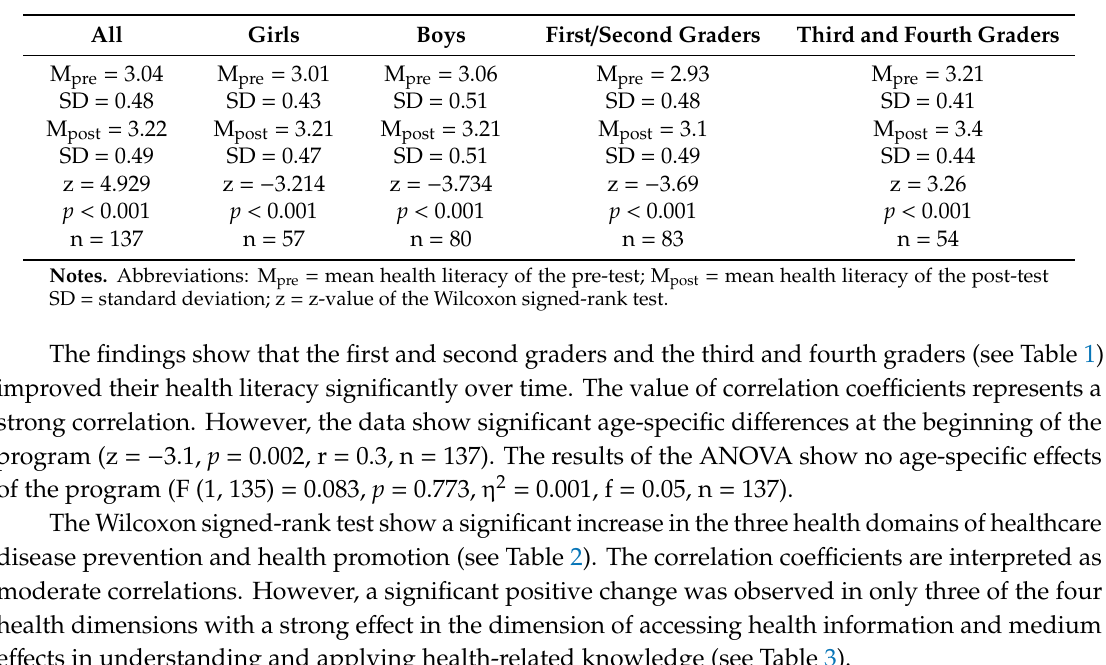
Table 1. Age- and gender-specific results.